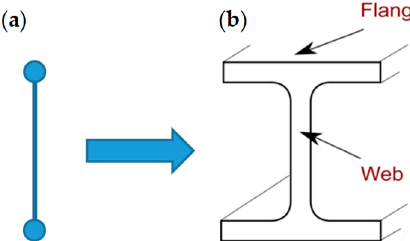
Figure 5. Concept of the straps/strips combined technique: Two FRP strips tied by CAM ribbons behave as ( a ) two mass points connected by a stiffness constraint, which is the ideal scheme of behavior of ( b ) a bent I-beam in its cross-section.